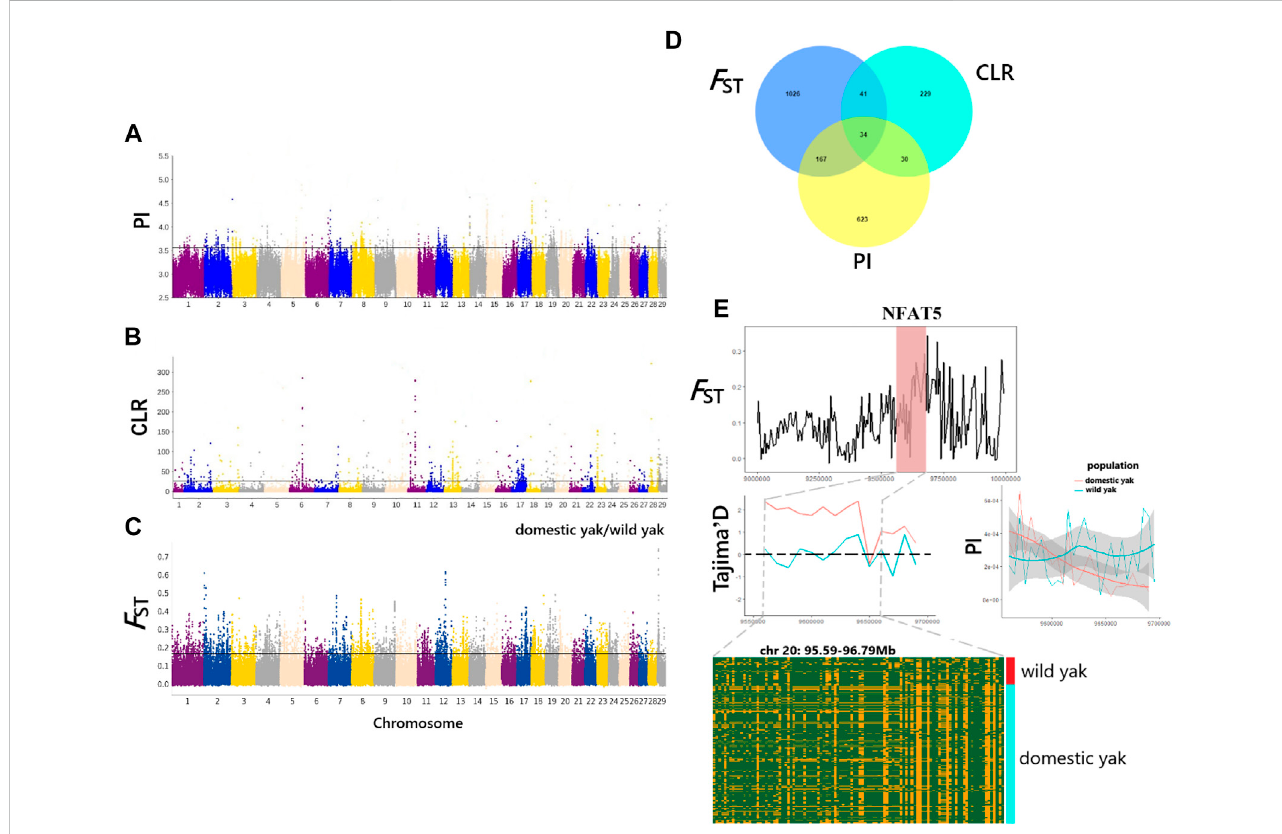
FIGURE 5 Genome-wide selection scan for positively selected genes (PSGs) in Qinghai yak using sliding window analysis (50-kb window size and 20-kb step size). (A) Manhattanplotofselectedsweeps bythePImethod. (B) Manhattan plotofselected sweeps bytheCLRmethod. (C) Manhattanplotofselected sweeps by the F ST method, based on domestic and wild yak populations. (D) Venn diagram showing the candidate genes identi fi ed by the CLR, PI, and F ST methods. (E) F ’ D, and PI of the NFAT5 gene region between wild and domestic ST , Tajima